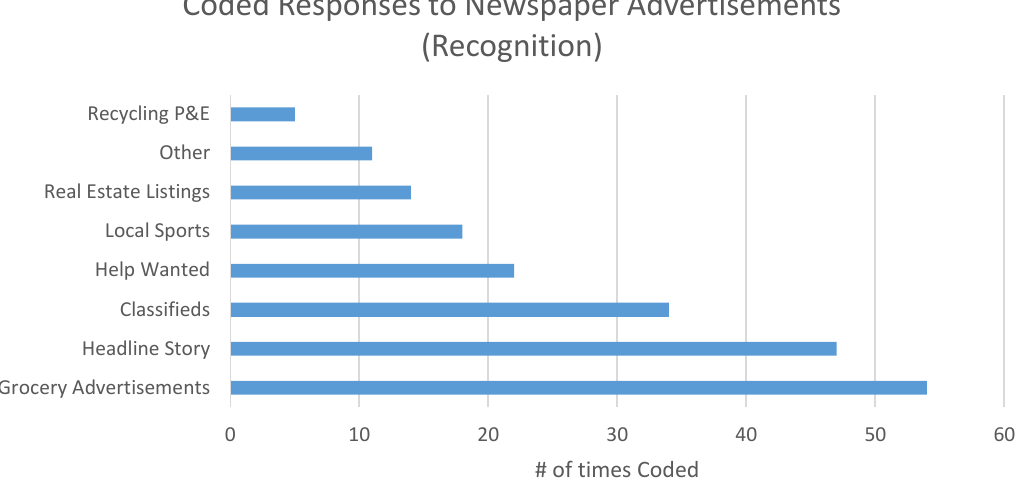
Figure 5. Coded Responses to Newspaper Advertisements (Recognition).